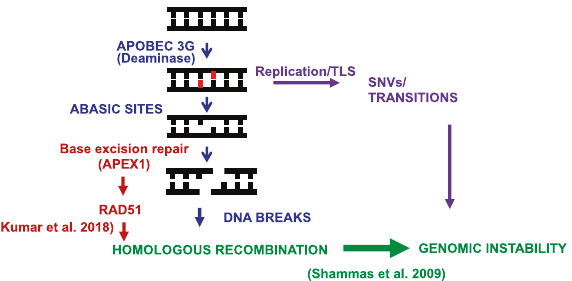
Fig. 6 Proposed model for the role of APOBEC3G in genomic instability in multiple myeloma. Elevated A3G-induced deaminase activity leads to generation of abasic sites. Processing of increased abasic sites then leads to increase in DNA breaks. Previous data from our laboratory demonstrate that APEX1, the nuclease which is involved in the repair of abasic sites by cutting the DNA 5 ′ to abasic site, is elevated and contributes to dysregulation of RAD51 and homologous recombination [29], a mechanism of genomic instabil- ity in MM [1]. Increased abasic sites by A3G and the replication stress caused by abasic sites can also contribute to genomic instability by increasing the likelihood of translesion synthesis